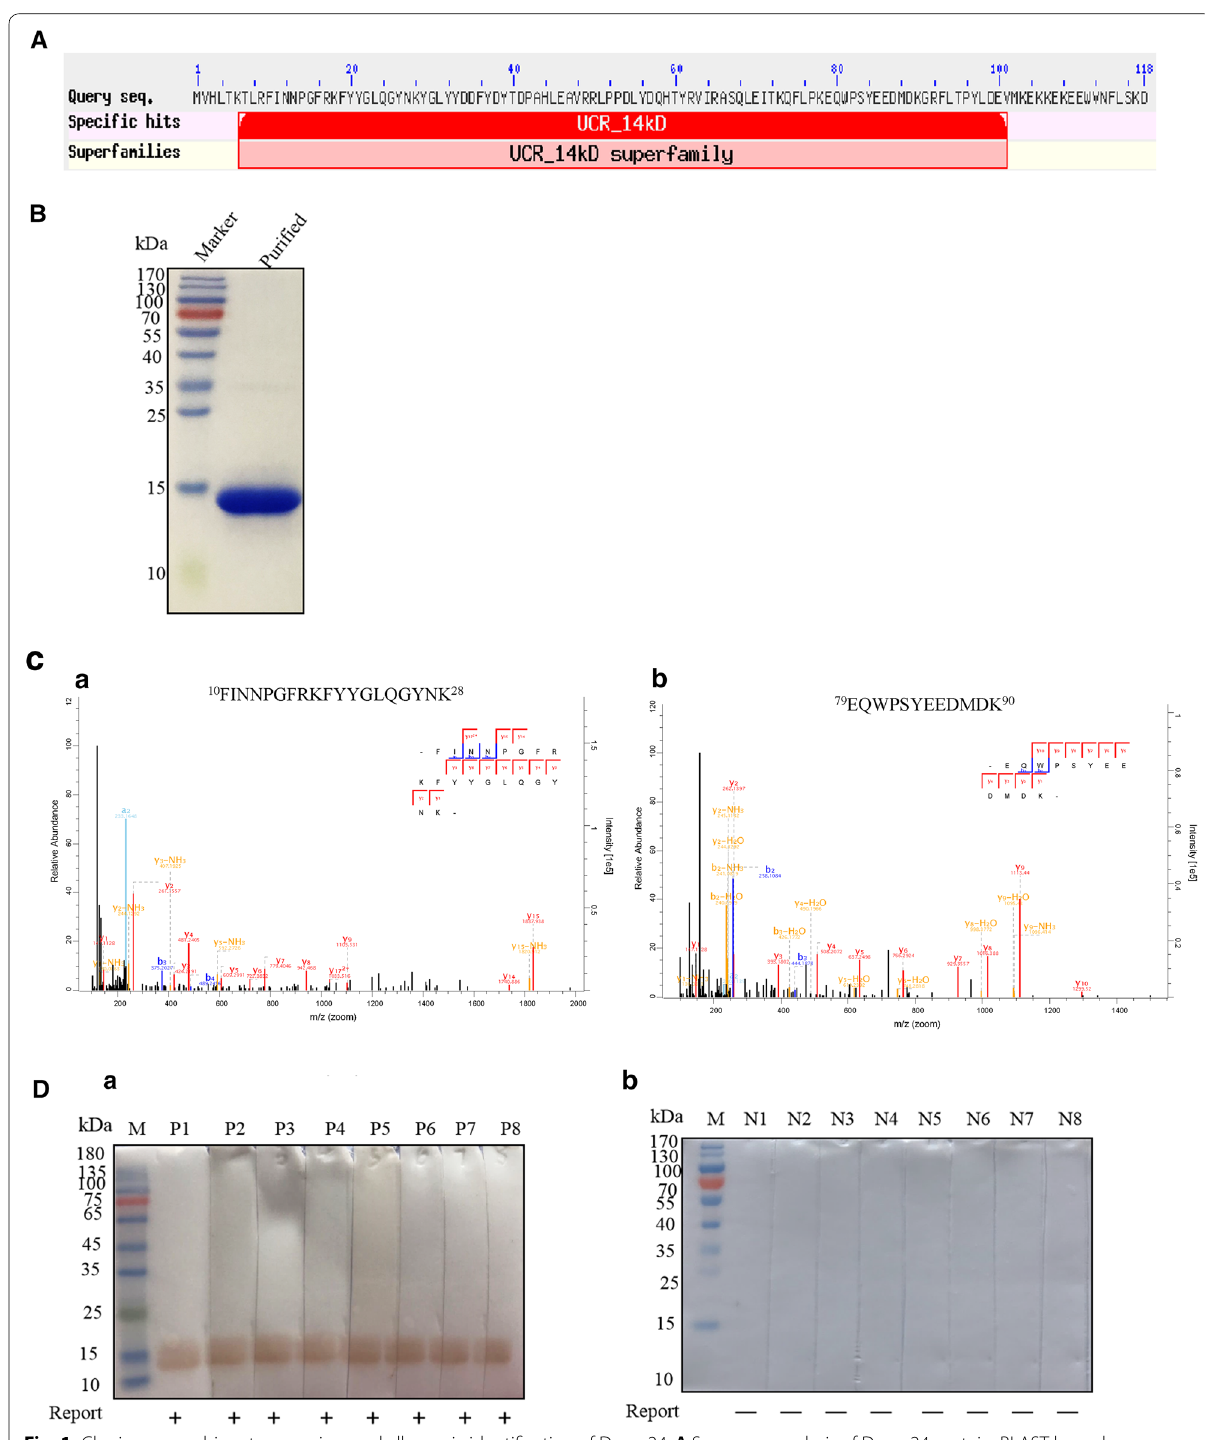
Fig. 1 Cloning, recombinant expression, and allergenic identification of Der p 24. A Sequence analysis of Der p 24 protein. BLAST homology comparison of Der p 24 and Der f 24 (GenBank No. AJK91617.1). After codon optimization, synthesized Der p 24 cDNA was subcloned into pET expression system to generate Der p 24 (theoretical molecular mass 14 kDa; GenBank accession no. KP893174.1). B SDS‑PAGE analysis of purified = rDer p 24 stained with Coomassie brilliant blue. C Peptide coverage of rDer p 24 based on MS analysis: 10–28aa peptide data shown in a and 79–90aa peptide data shown in b . D IgE binding activity determined by IgE‑western blots of rDer p 24 with individual sera from 8 HDM‑allergic patients ( a ) and 8 healthy non‑allergic individuals ( b